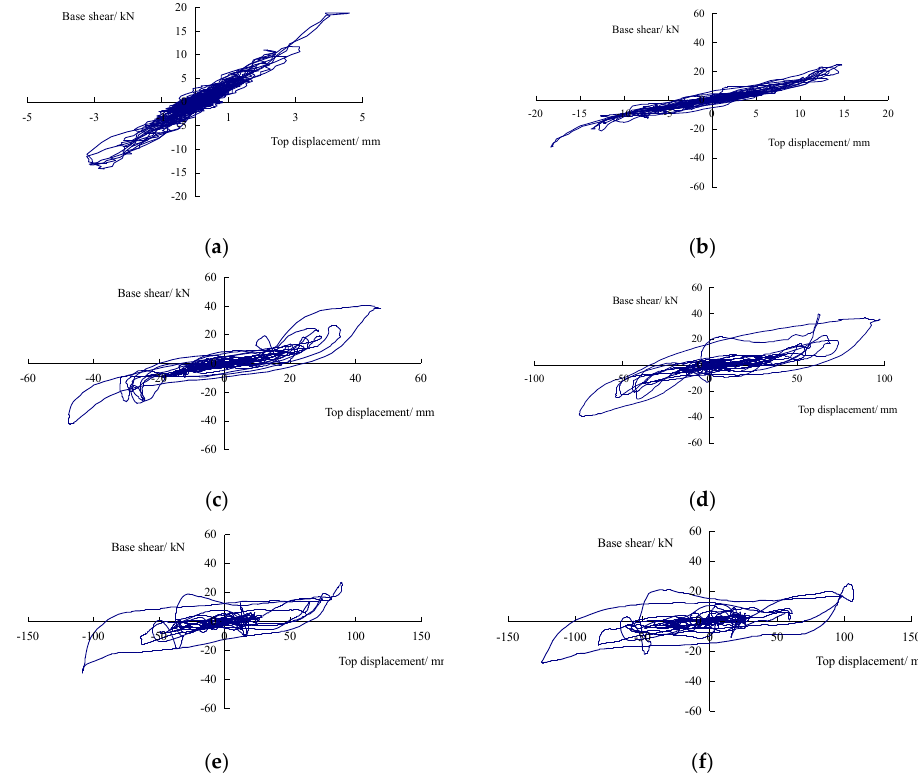
Figure 10. Hysteresis curve of the test model. ( a ) PGA = 0.08 g; ( b ) PGA = 0.26 g; ( c ) PGA = 0.46 g; ( d ) PGA = 0.59 g; ( e ) PGA = 0.66 g; ( f ) PGA = 0.91 g.